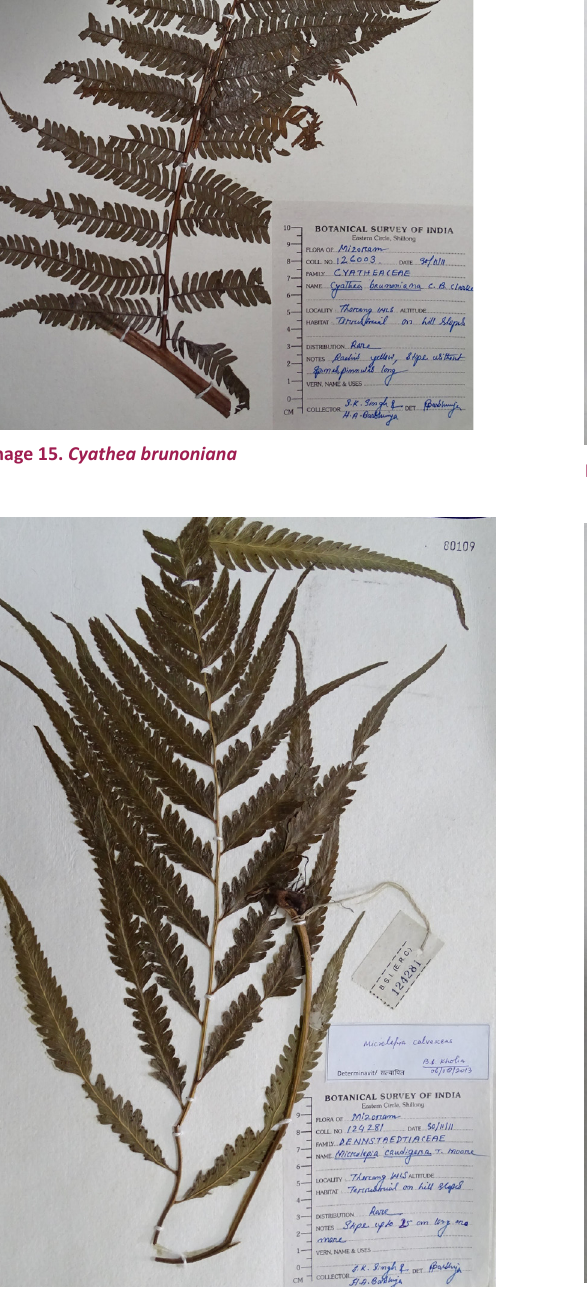
Image 17. Microlepia calvescens Image 18. Microlepia